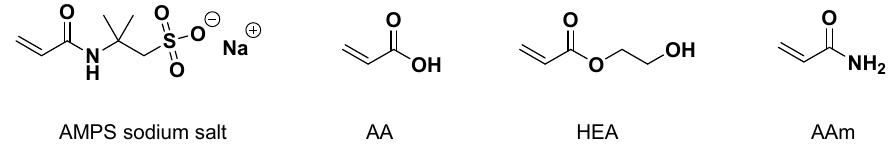
Figure 1. Chemical structures of AMPS sodium salt and comonomers.